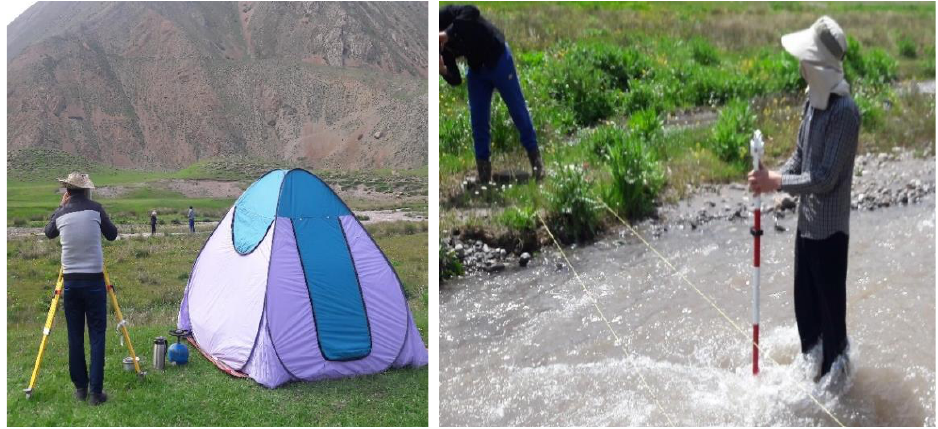
Figure 4. Surveying in the studied reaches. Table 4. The number of surveyed points in studied reaches.